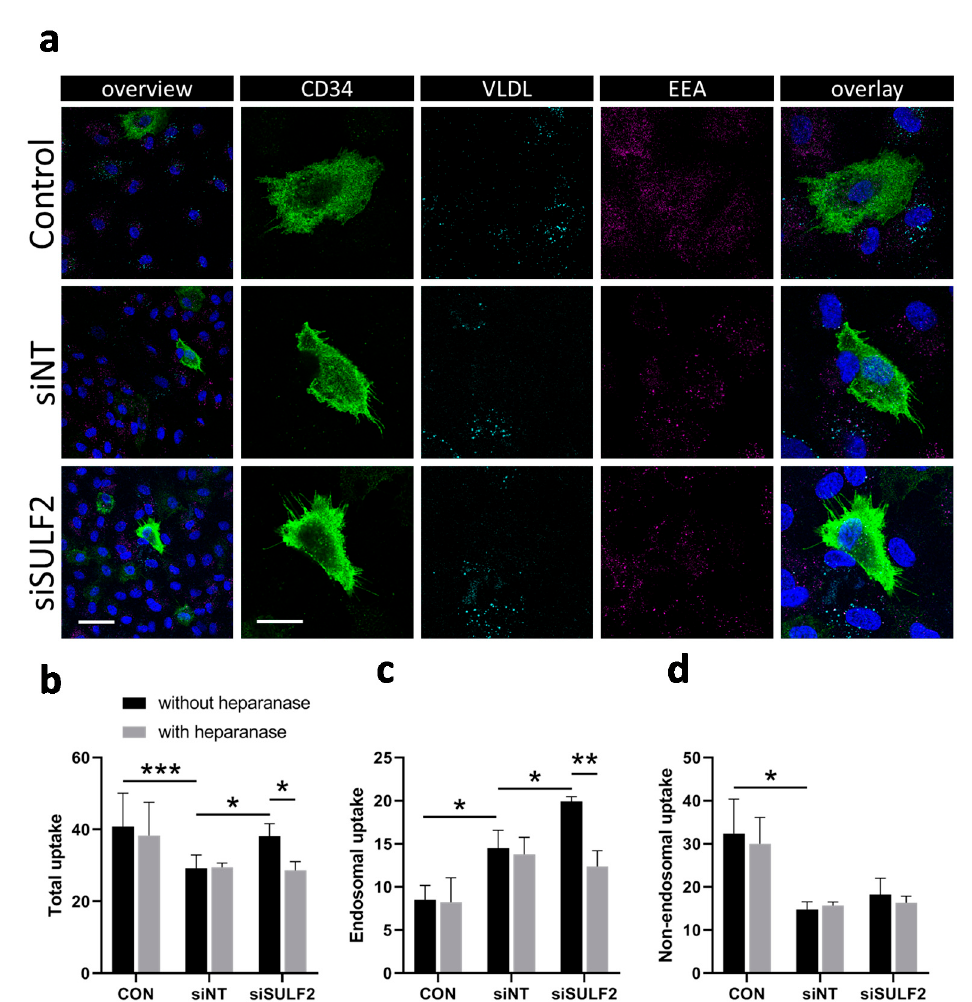
Figure 5. Knockdown of SULF2 leads to increased uptake of VLDL in non-tip cells. ( a ) Demonstration of endosomal uptake of fluorescently-labeled VLDL by CD34 - but not CD34 + cells. Staining of CD34 (tip cells, green), VLDL (cyan), endosomes (EEA, magenta), and nuclei (DAPI, blue) in HUVECs and overlaid images at low (bar = 50 µm) and higher (bar = 20 µm) magnification. ( b – d ) Quantification of total, endosomal, and non-endosomal uptake of fluorescently-labeled VLDL by HUVECs after siRNA-mediated knockdown of SULF2 . Heparanase was used as a control as it removes all HS chains from HSPG proteins. Cells were stained with DAPI and EEA1 for nuclei and endosomes. The numbers of VLDL particles per cell were counted using Matlab and overlap with EEA1 staining was considered to indicate endosomal uptake. Students ’ t -tests were used to calculate statistical differences (* p < 0.05, ** p < 0.01, *** p < 0.001) using HUVECs of three donors and at least seven cells per condition in each experiment.